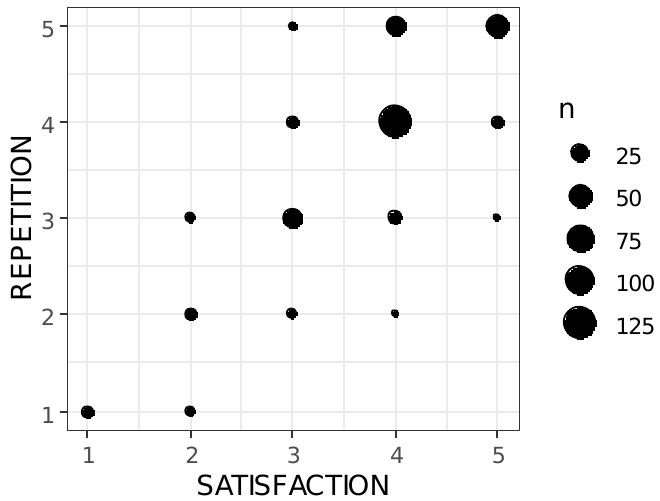
Figure 1. Relationship between consumers’ overall satisfaction and intention to repeat.